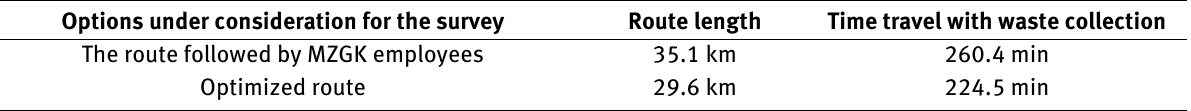
Table 8: Comparison of the length of the routes and their travel time for the compared variants Options under consideration for the survey Route length Time travel with waste collection The route followed by MZGK